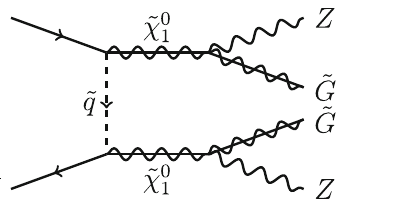
Fig. 2 Neutralino (decaying to Z plus gravitino) production mechanisms considered in the SUSY dark matter model